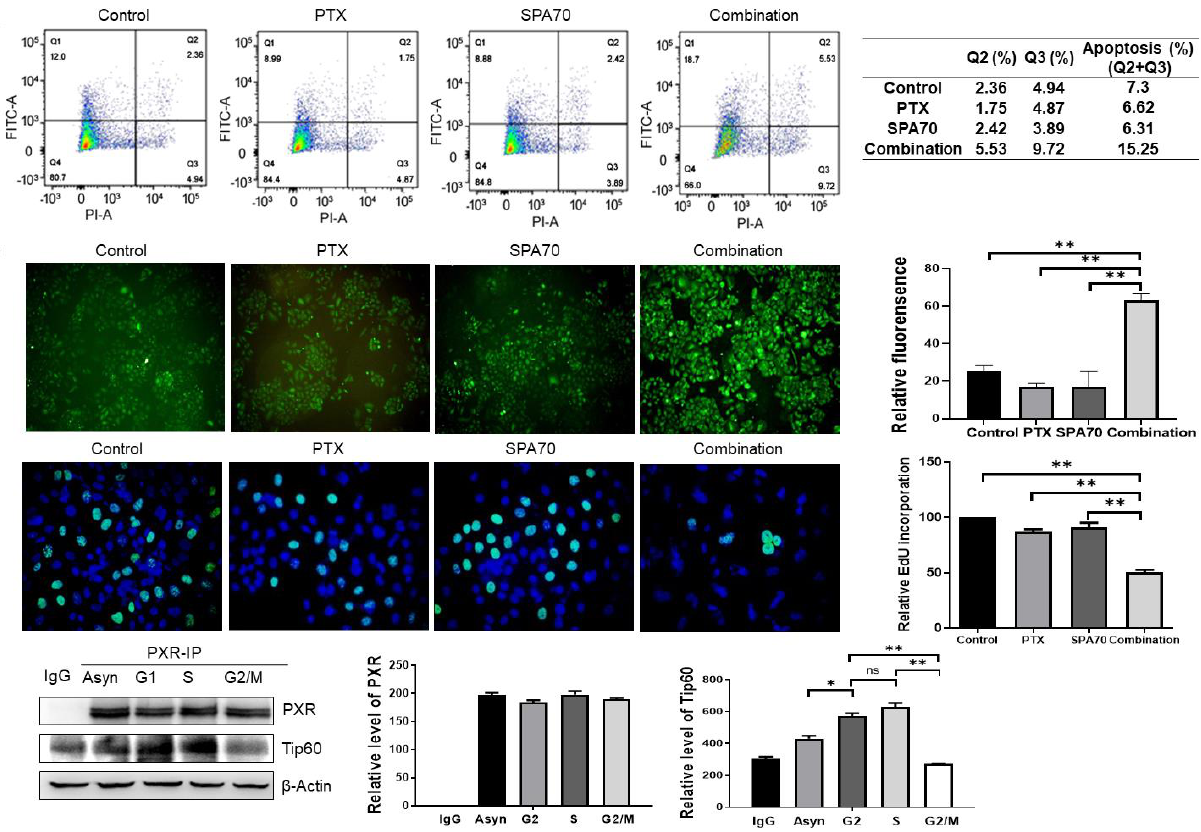
Figure 4. Combination treatment induces apoptosis and compromises EdU incorporation. All the experiments were conducted with 2 nM PTX, 10 µ M SPA70, or combined usage for 48 h. ( A ) Combination regimen induced the highest apoptosis in A549/TR cells within all groups as shown by annexin V-FITC/PI staining. Apoptosis fraction was calculated by the summarization of coverage percentage in Q2, and Q3. ( B ) Combination regimen produced the highest ROS level in A549/TR cells among all groups by DCFH-DA probe incubation with live cells. The photographs were taken by fluorescence microscopy (200 × ). ( C ) Combination regimen inhibited EdU incorporation in A549/TR cells among all groups. Merged images with green (EdU-488) and blue (DAPI) were displayed and EdU fluorescence staining was quantified. The photographs were taken by fluorescence microscopy (200 × ). ( D ) Combination regimen-treated cells were held in different cell cycles and precipitated with the indicated antibody. Western blot detection shows increased interaction between Tip60 and PXR mainly in S-phase. *, p < 0.05; **, p < 0.01, compared with indicated groups. Ns means no statistical